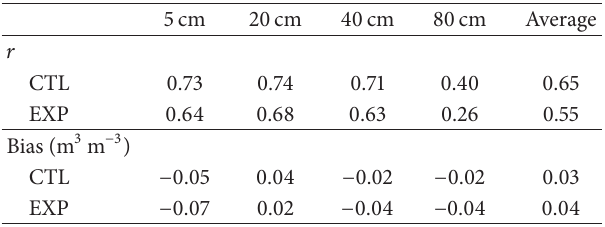
Table 3: Statistical results of simulated soil liquid water content from CTL and EXP at ZS